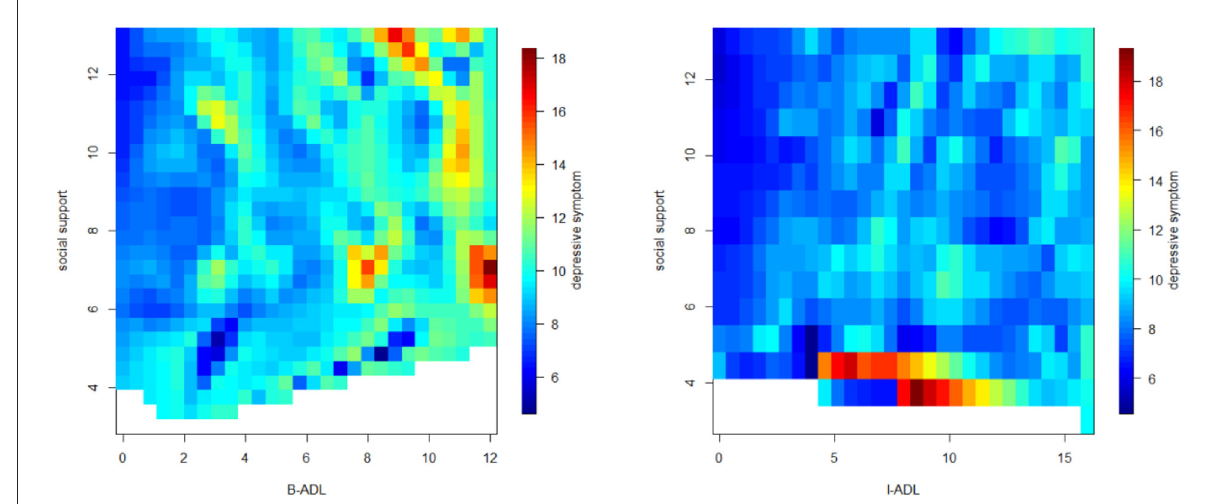
FIGURE3 Association between disability, social support, and depressive symptoms in the elderly.